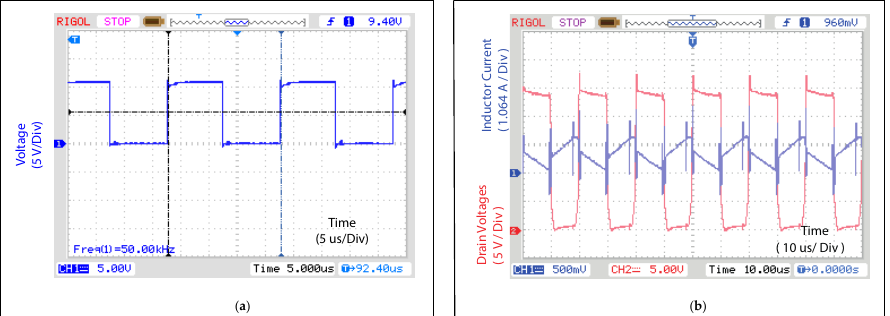
Figure 8. Fixed frequency operation of the converter. ( a ) switching signal; ( b ) drain voltage and inductor current.